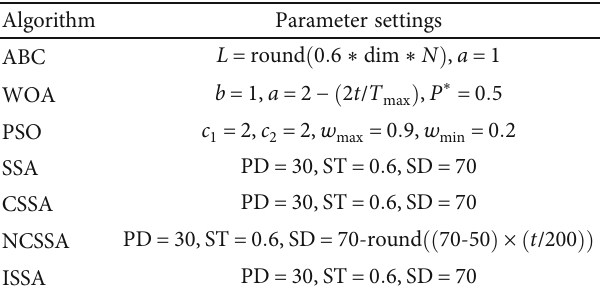
Table 2: Parameter